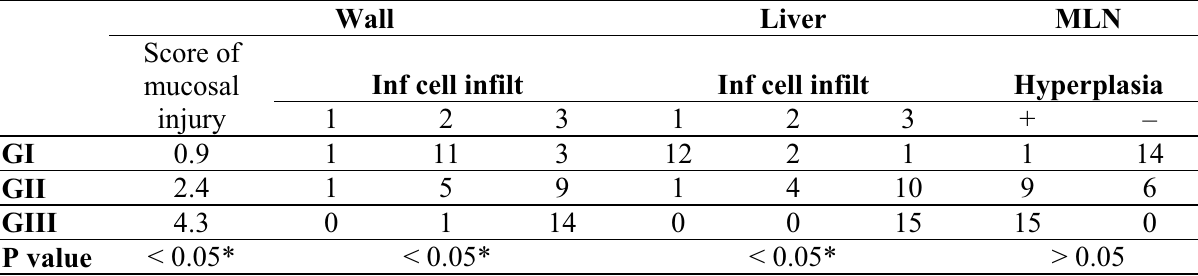
TABLE 4 - The local and remote inflammatory